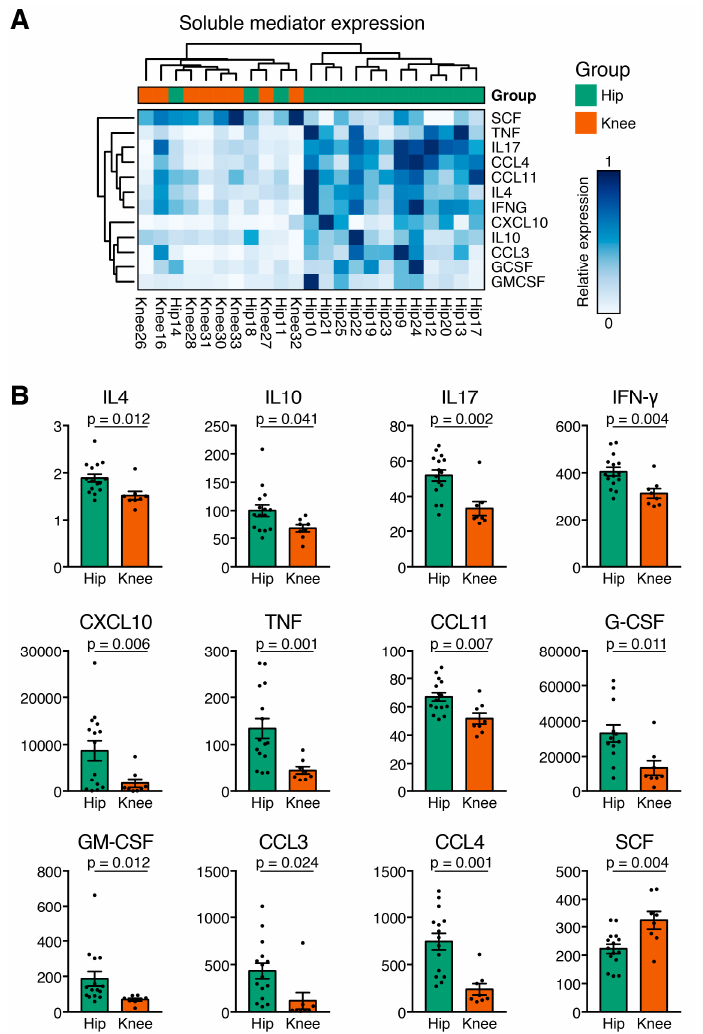
Figure 3. Cytokine expression profiles in synovial membrane mononuclear cells distinguish hip and knee osteoarthritis. ( A ) Heatmap visualizing relative expression values of statistically significantly, differentially released cytokines between hip and knee OA. Rows and genes were clustered in an unsupervised manner. Samples clustered in a similar fashion to Figure 2A and relative expression revealed two distinct soluble mediator programs, suggesting coordinated cytokine programs. ( B ) Dot plots of the 12 cytokines that are overexpressed in one subtype of OA compared to the other. The unpaired t -test was performed to assess the differences between end-stage hip and knee osteoarthritis (OA) SM samples due to the predominantly Gaussian distribution. For cytokines which did not show Gaussian distribution, a Mann–Whitney U-test was performed. All reported p -values are two-tailed. A p -value < 0.05 was considered to show a statistically significant difference.